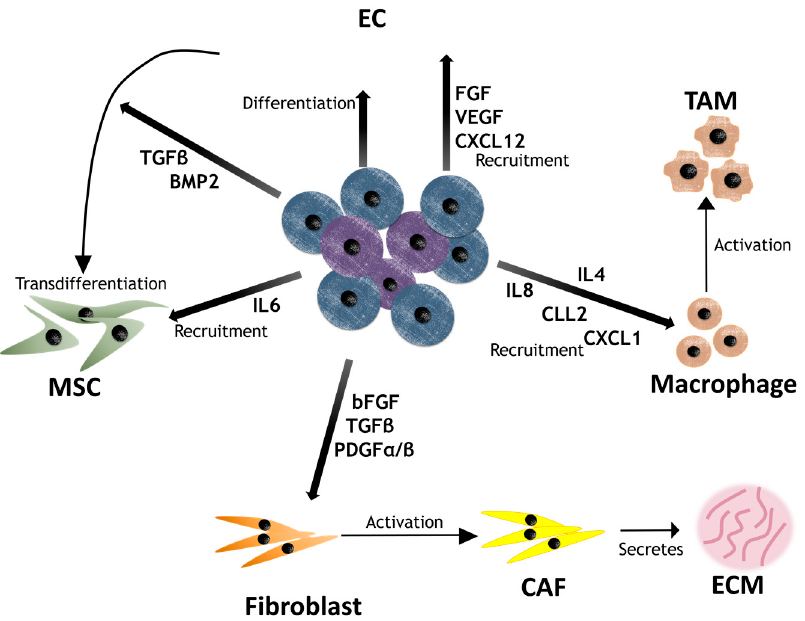
Figure 3. Factors secreted by CSCs (represented as purple cells) promote the recruitment and activation of niche components, indicating that the relation of CSC-niche is not unidirectional.